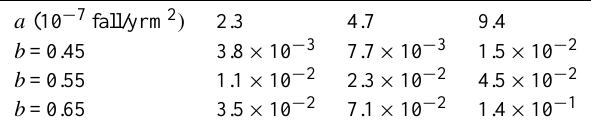
Table 2. Impact frequency (event per year) with a minimal kinetic energy of 0.025kJ, of an element at risk of width 0.5m, located at the foot of the 150m high Saint-Eynard rock